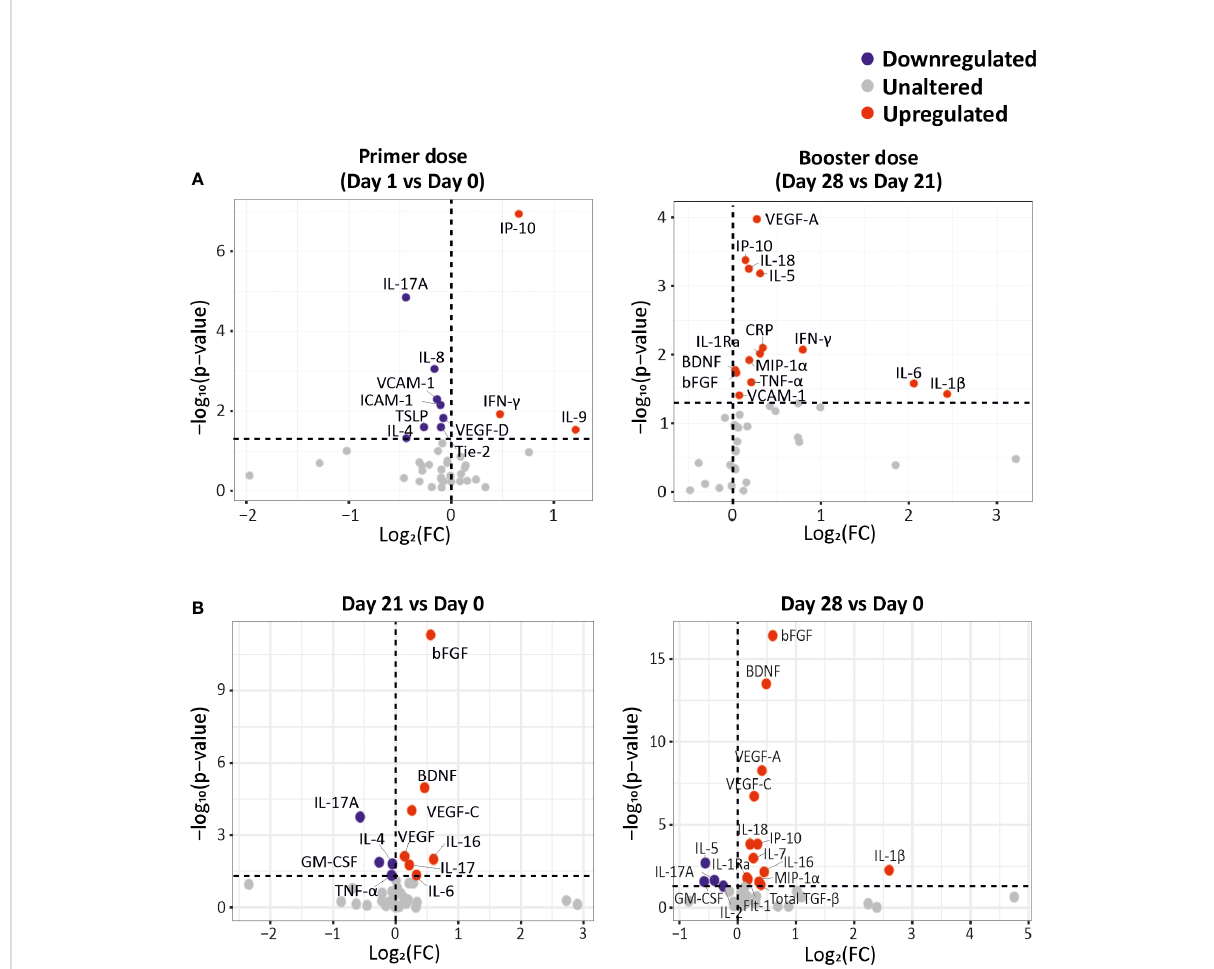
FIGURE 2 CCG alterations as a response to primer and booster dose vaccinations in cancer patients. (A) Differentially expressed CCGs after the administration of the primer and booster doses, compared to the CCG levels prior to vaccine administration. (B) Differentially expressed CCGs at day 21 and day 28, compared with baseline day 0. P -values were calculated using paired t-test. The vertical dotted line represents no change. The horizontal dotted line represents a p -value of